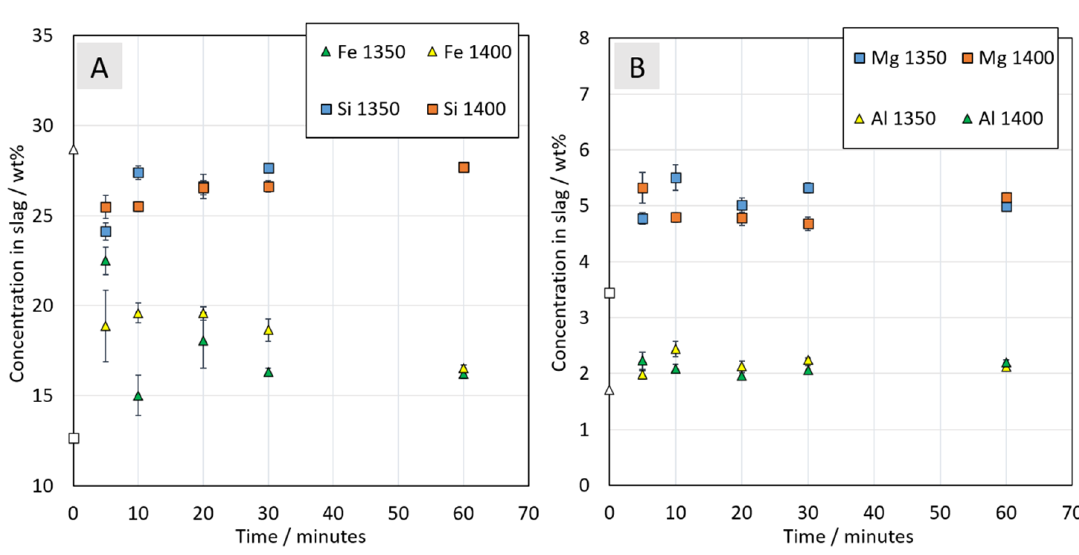
Figure 12. Concentrations of major elements ( A ) iron and silicon, ( B ) magnesium and aluminum in the slag phase at 1350 °C and 1400 °C as a function of contact time in argon atmosphere. The values at 0 minutes correspond to the elemental concentrations in the starting mixture.